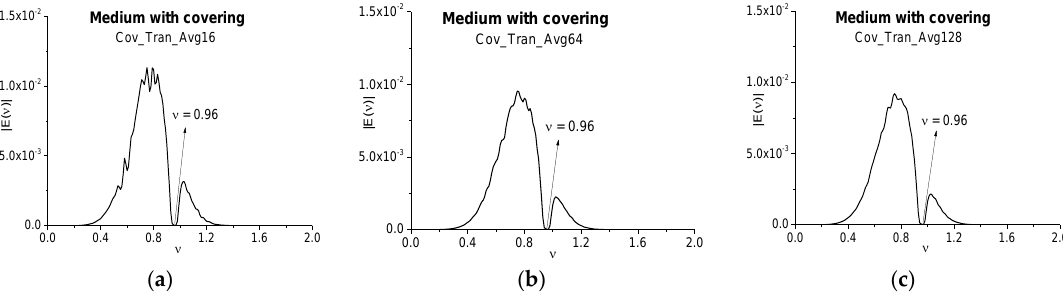
Figure 12. Fourier spectra of the averaged signals Cov_Tran_Avg16 ( a ), Cov_Tran_Avg64 ( b ), Cov_Tran_Avg128 ( c ) transmitted through the medium with covering and calculated in the time interval t = [0, 100].